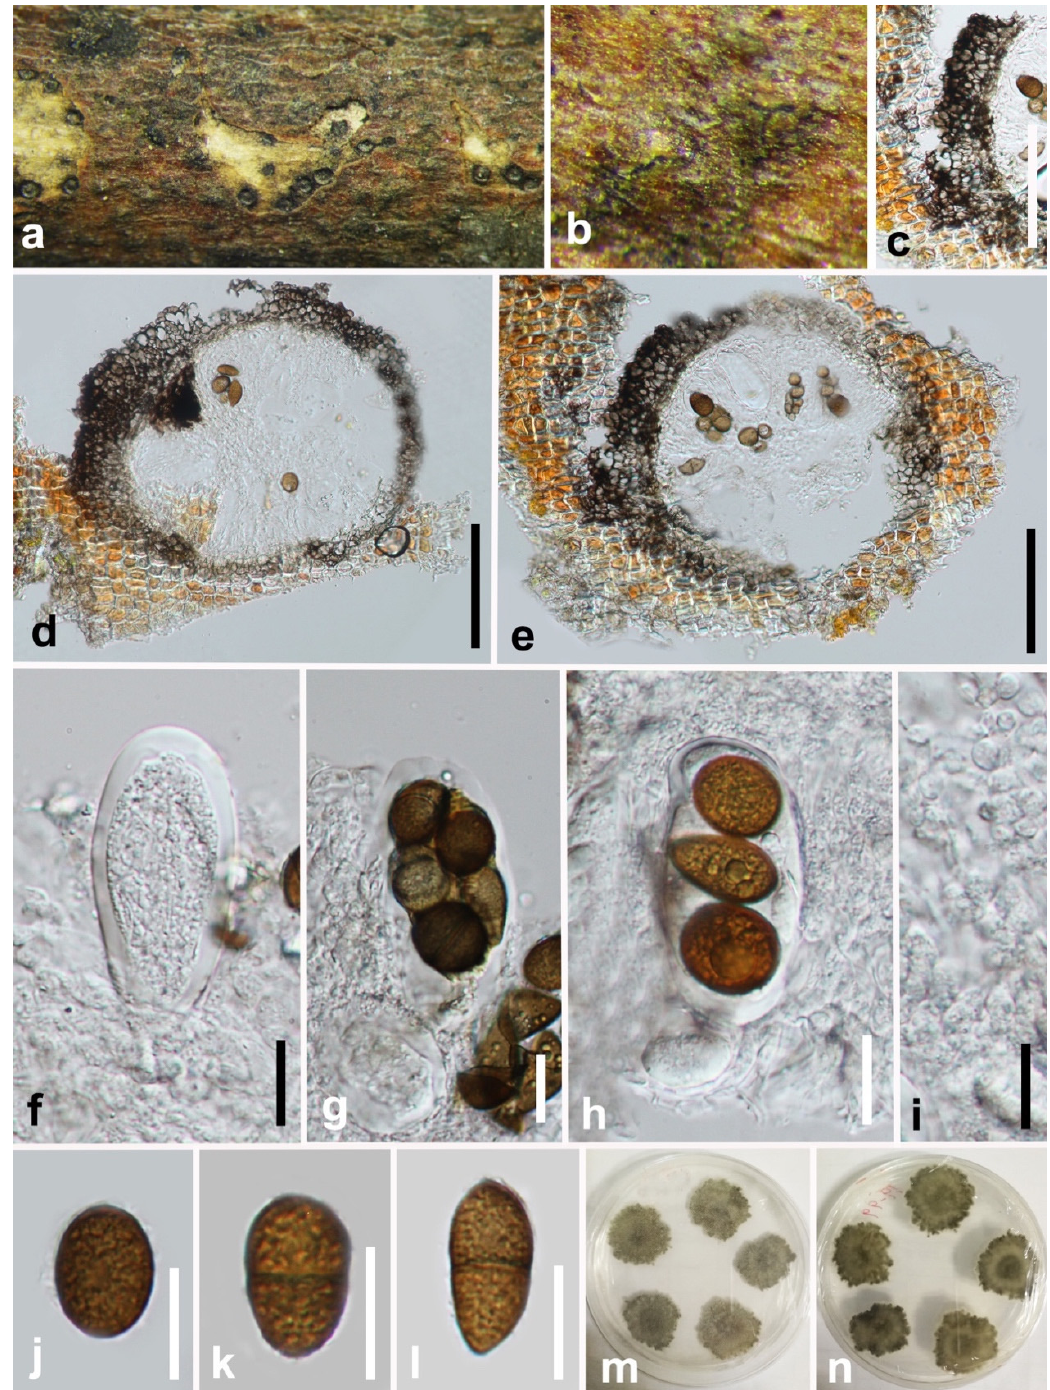
Figure 5. Sardiniella celtidis (GZAAS 19-1967). ( a , b ) Appearance of ascomata on decaying wood. ( c ) Peridium. ( d , e ) Vertical section of ascomata. ( f ) Immature ascus. ( g , h ) Mature asci. ( i ) Pseudoparaphyses. ( j – l ) Brown, one-septate ascospores. ( m , n ) Five-day-old culture on PDA (OXOID CM0139) from above and below. Scale bars: ( c – e ) = 100 µm, ( f – l ) = 20 µm.